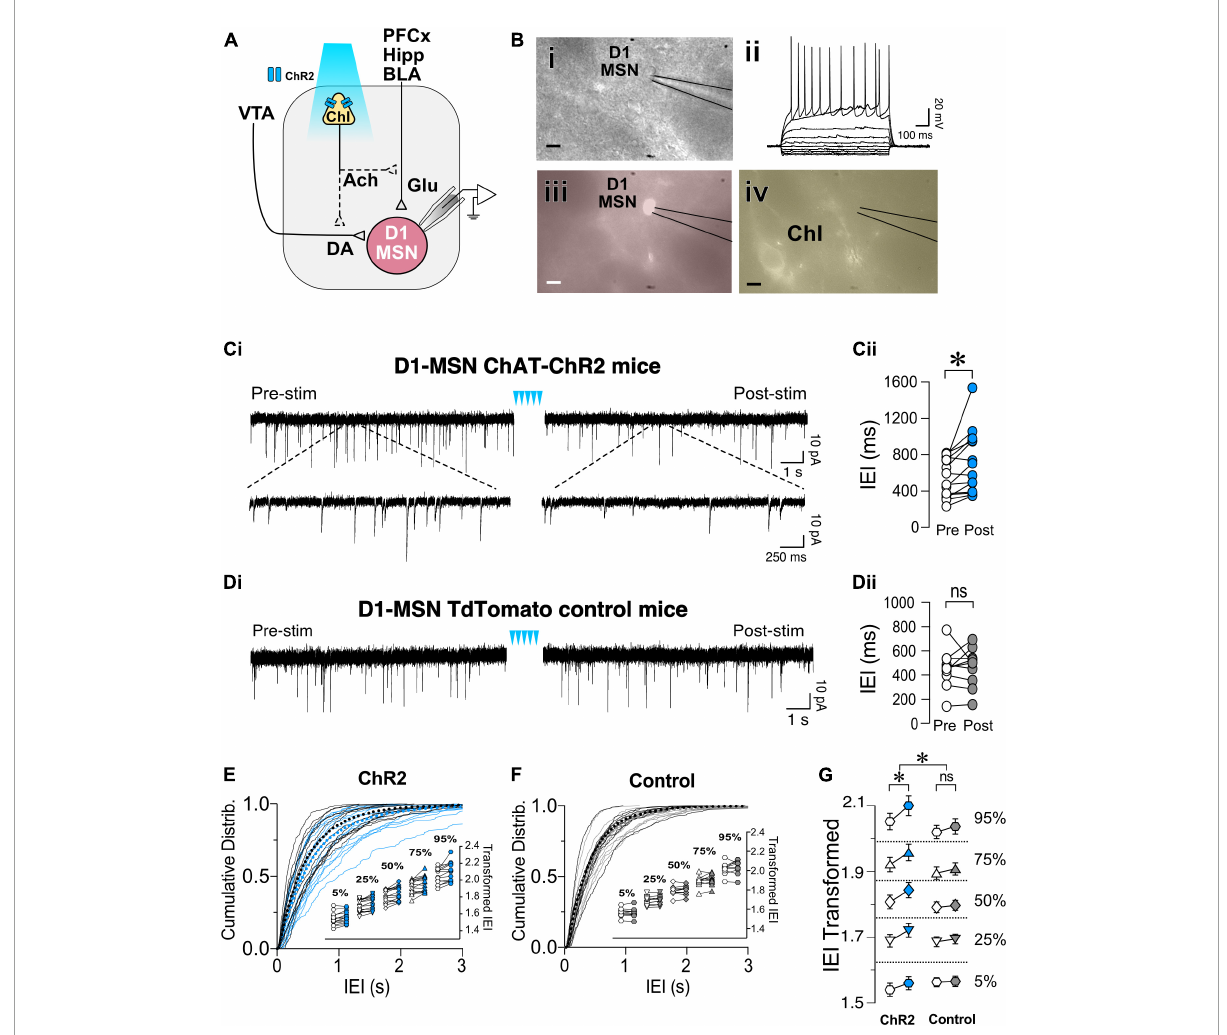
FIGURE2 Optogenetic stimulation of ChIs decreases sEPSCs frequency in D1-MSNs. (A) Schematic of the experimental setup: whole cell recording of D1-MSNs sEPSC during optogenetic stimulation of ChIs. (B) Same slice images of representative MSNs [ (i) , DIC], corresponding IV traces to confirm MSN identity (ii) , red-epifluorescence to verify the cell is D1R+ (iii) , and eYFP epifluorescence of ChI cell in proximity of the recording (iv) . Scale bar 10 um. (Ci) Representative sEPSCs in D1-MSNs in ChAT-ChR2 mice before (Pre) and after (Post) ChI optogenetic stimulation (blue arrowheads). (Cii) Average sEPSCs inter-event intervals (IEI) in Pre (white circles) and Post (blue circles) ChI optogenetic stimulation in ChAT-ChR2 D1-MSNs ( n = 14). (Di) Representative traces of sEPSCs in D1-MSNs of tdTomato control mice before (Pre) and after (Post) ChI stimulation. (Dii) Average EPSCs inter-event intervals (IEI) in Pre (white circles) and Post (gray circles) ChI optogenetic stimulation in control tdTomato D1-MSNs ( n = 10). (E) Cumulative frequency distribution of D1-MSN sEPSCs IEI in ChAT-ChR2 mice group Pre (black traces) and Post (blue traces) ChI optogenetic stimulation. Each solid line represents a neuron. Average traces for Pre and Post conditions are shown in dotted black and blues lines, respectively. Inset. Cumulative distributions of ChAT-ChR2 D1-MSNs EPSCs IEIs broken into percentiles of distribution to quantify median (50%), shoulders (25 and 75%), and extreme values (5 and 94%) of distribution, that are 1 10 transformed to normalize the distribution. (F) Cumulative frequency distribution of D1-MSNs inter-event intervals (IEI) of sEPSCs before (Pre, black lines) and after (Post, gray lines) ChI optogenetic stimulation in tdTomato control mice. Each solid line represents a neuron. Average traces are shown in dotted black and blues lines for Pre and Post conditions, respectively. Inset. Same as inset in panel (E) , but in tdTomato D1-MSN controls. (G) Percentiles of cumulative distribution of transformed IEIs of EPSCs in ChAT-ChR2 D1-MSNs (Pre, white circles, Post, blue circles) and control TdTomato D1-MSNs (Pre, white circles, Post, gray circles). * p < 0.05, ns, no significant